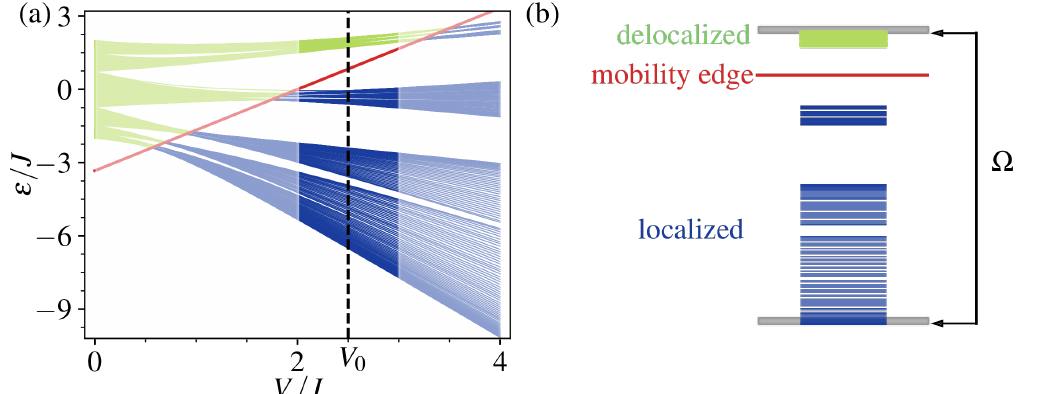
Figure 1: Schematic of the coupling between localised and delocalised states via the periodic drive. (a) The energy spectrum of the undriven Hamiltonian (1), where the colour shows the scaling of the inverse participation ratio with system size, with green corresponding to the delocalised states ( ∼ L − 1 ) and blue, localised states ( ∼ L 0 ). The red line denotes the mobility edge. (b) The energy levels corresponding to V (denoted by the black dashed line in (a)) 0 where a periodic drive with frequency Ω chosen to be slightly smaller than the bandwidth couples the delocalised and localised states approximately within the gray shaded